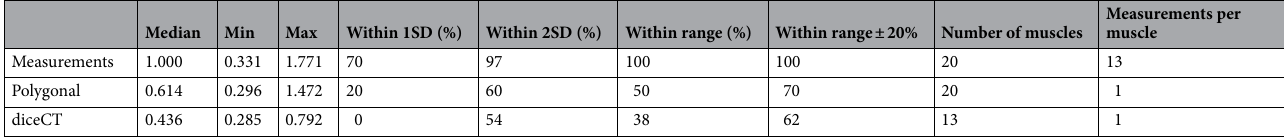
Table 1. Comparison between measurements and muscle masses calculated from the 3D models for the Nile crocodile. “Min” and “Max” = minimum and maximum relative muscle mass within dataset; SD standard deviation.